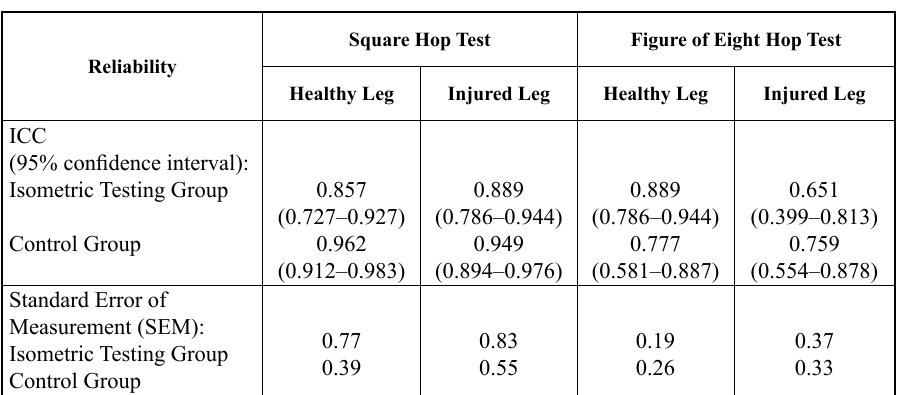
Table 3. Hop test